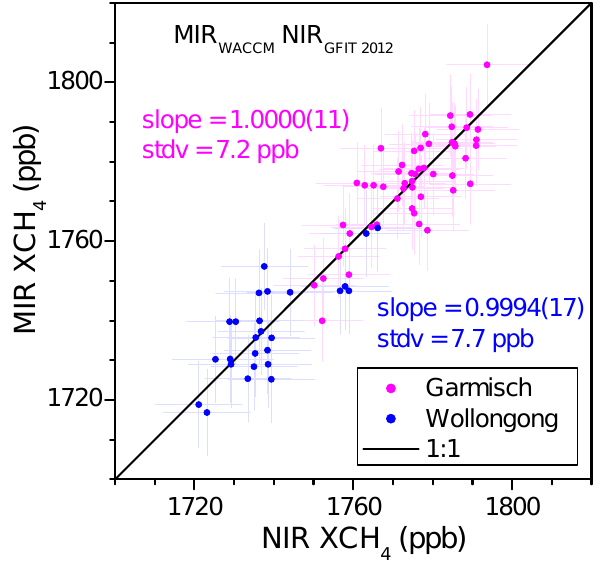
Fig. 10. Scatter plot of MIR and NIR monthly means, both se- ries retrieved with the standard retrieval a prioris (similar to Fig. 4a) but using the recent update GFIT ver. 4.8.6 (release ggg 2012 July